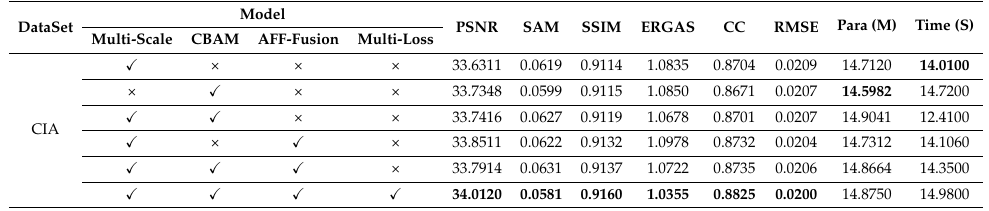
Table 3. Ablation experiments on CIA dataset.